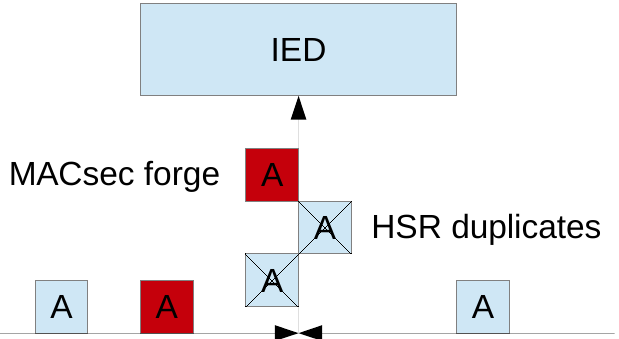
Figure 11. An HSR frame is forged, and correct frames are discarded by HSR processing because they have already arrived. MACsec processing in the end node discards the frame because it is a forge. Frame A never arrives to the intended destination.